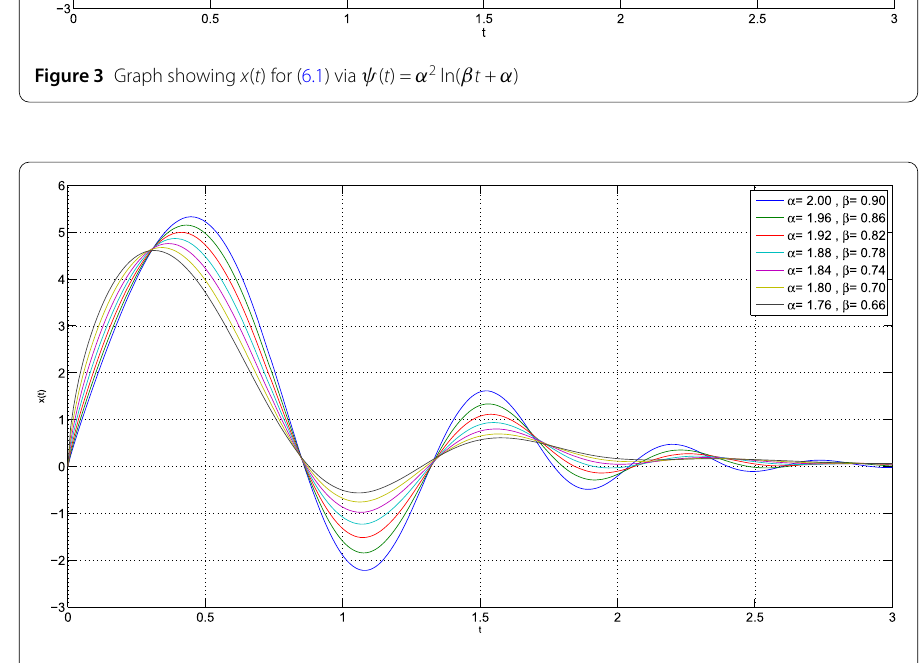
Figure 4 Graph showing x ( t ) for (6.1) via ψ ( t ) = t α + t